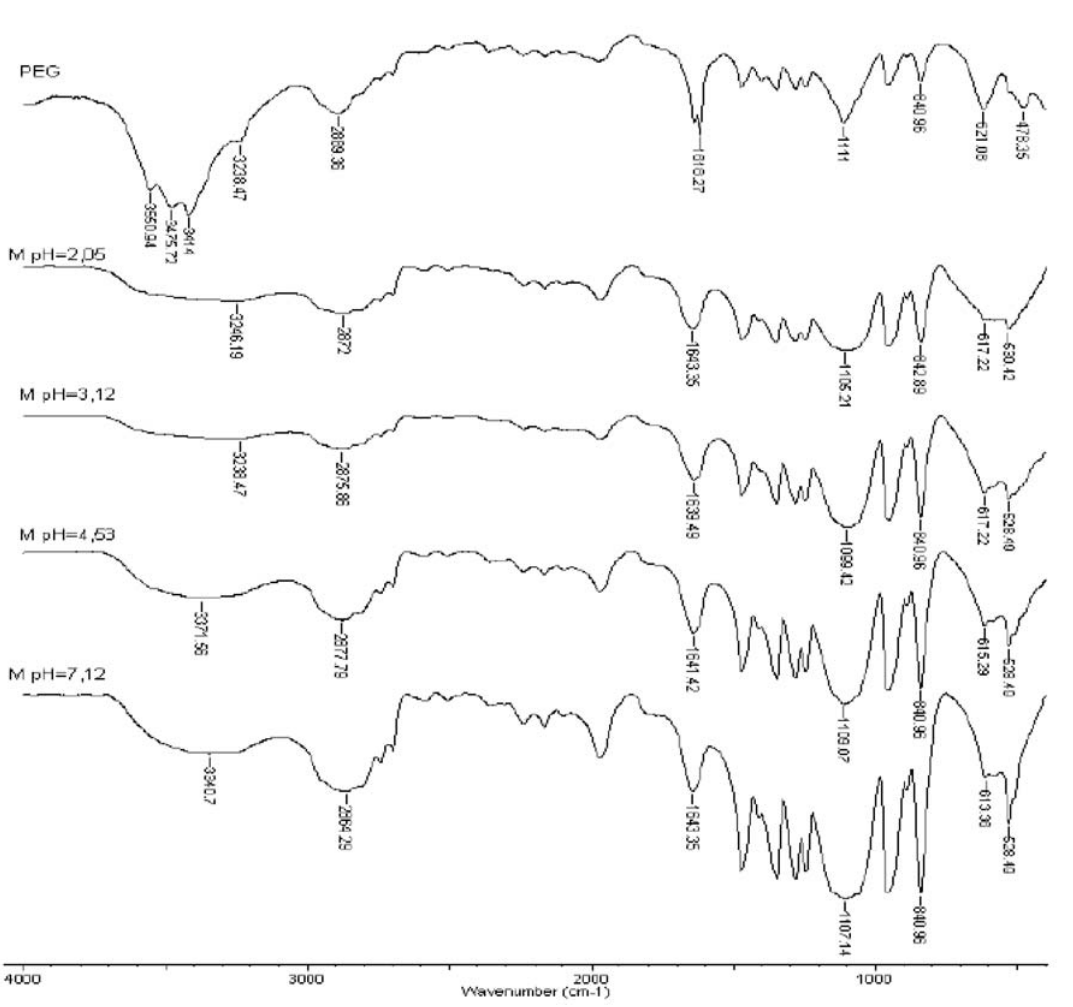
Fig. 1 IR spectra of 40 % PEG and of the extracted PEG (blank, M), for the four values of (NH 4 ) 2 SO 4 extractant